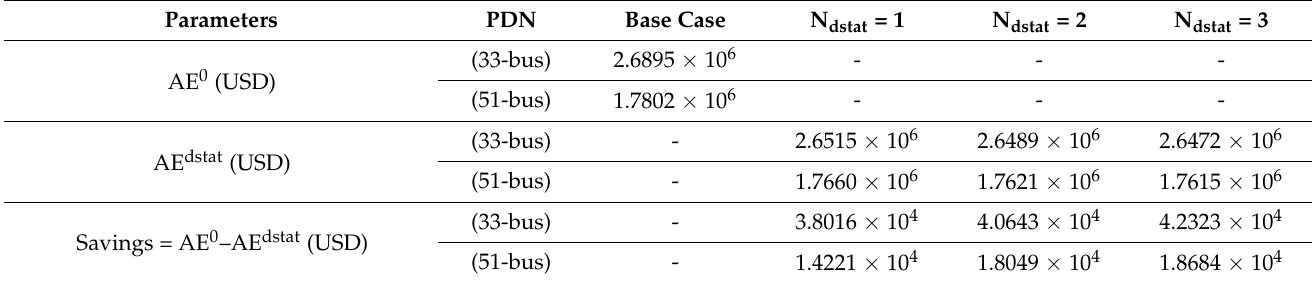
Table 6. Economic analysis of the PDNs with and without allocation of